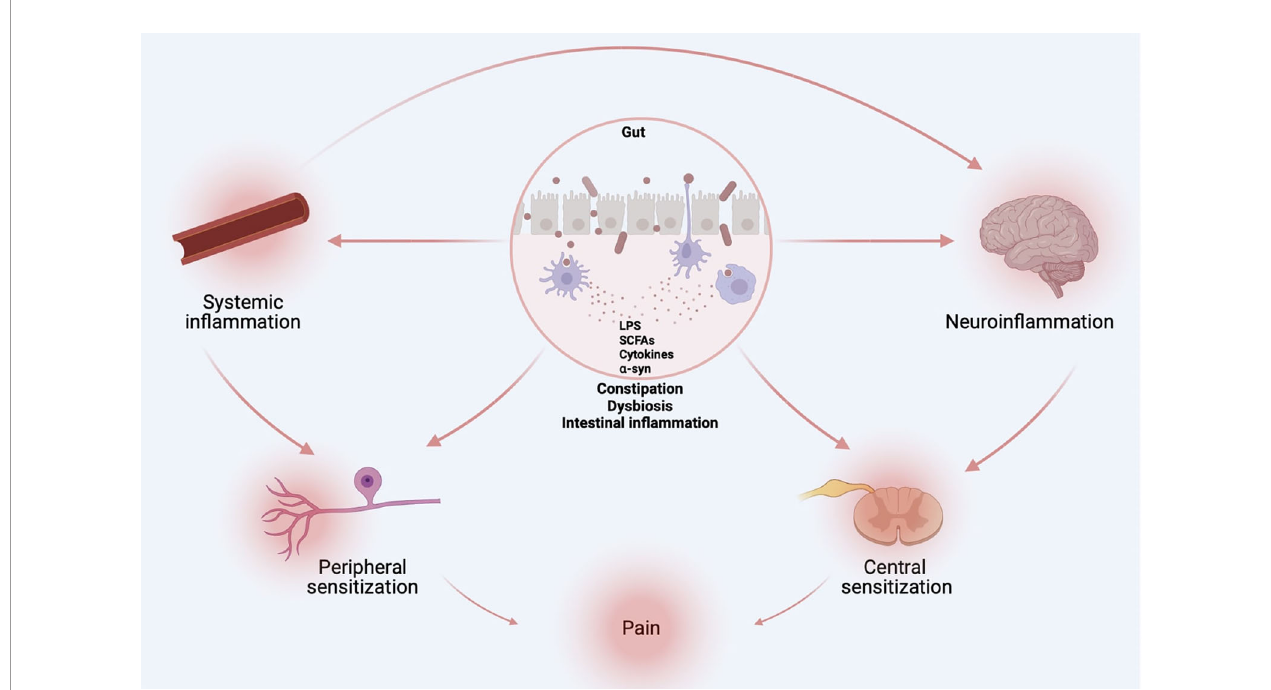
FIGURE 4 | Origins of PD-induced pain. Gut dysbiosis, altered peripheral and central immunity, and increased local (i.e., gut) and systemic cytokine content, as well as increased gut-brain barrier and BBB permeability are likely drivers of sensory hypersensitivity in PD. Figure created with